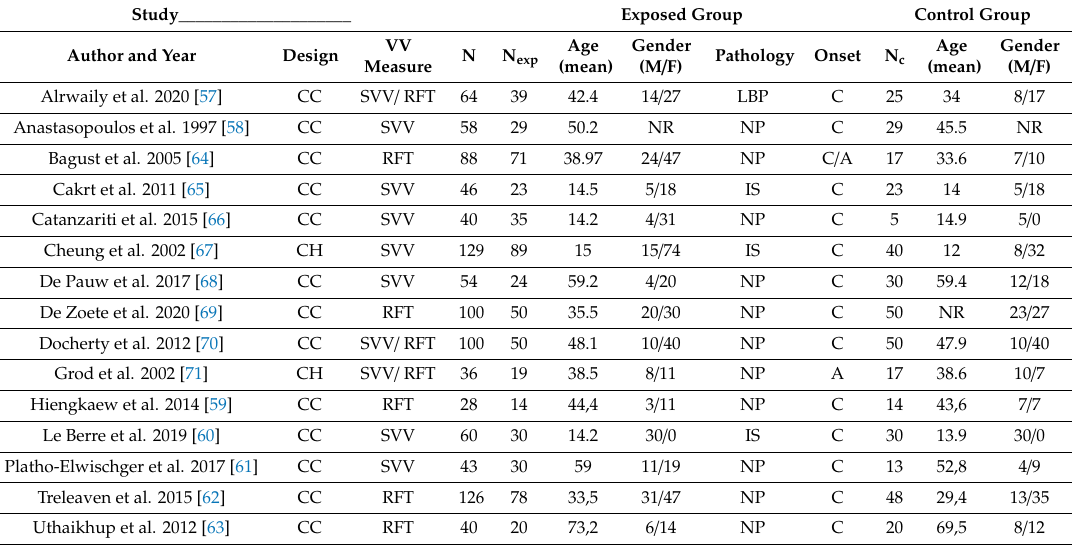
Table 2. Main characteristics of the studies included in the meta-analysis.